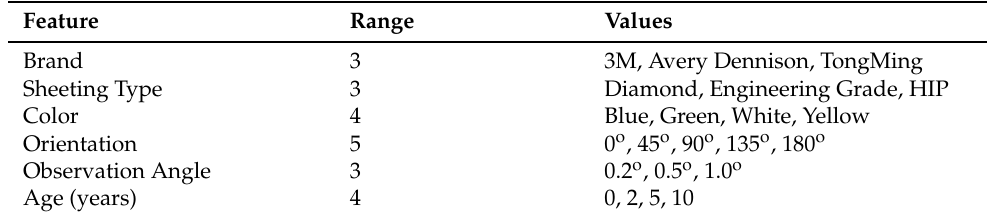
Table 1. Summary of sign sheeting surveyed during the field study.